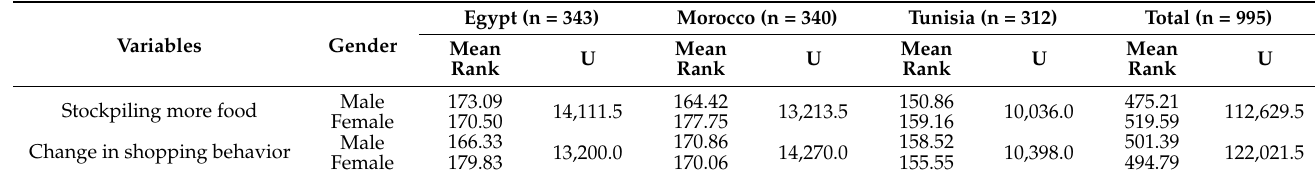
Table 7. Effects of gender on some food shopping behaviors (n =